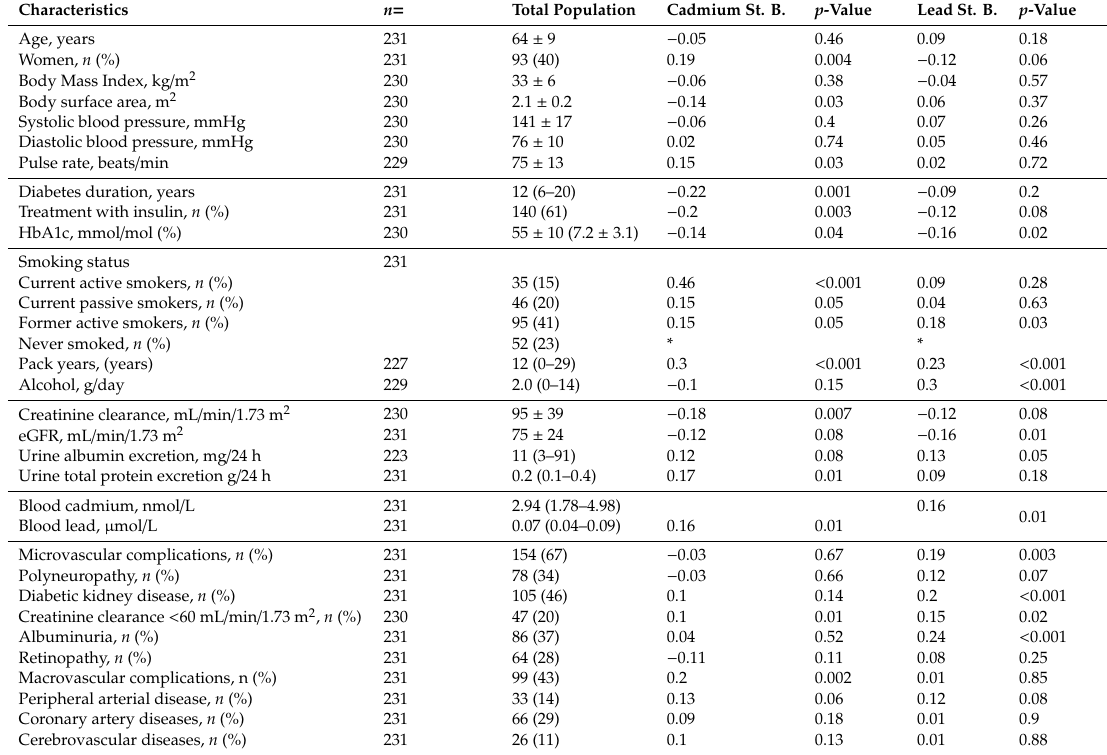
Table 1. Baseline characteristics and univariate associations with Cd and